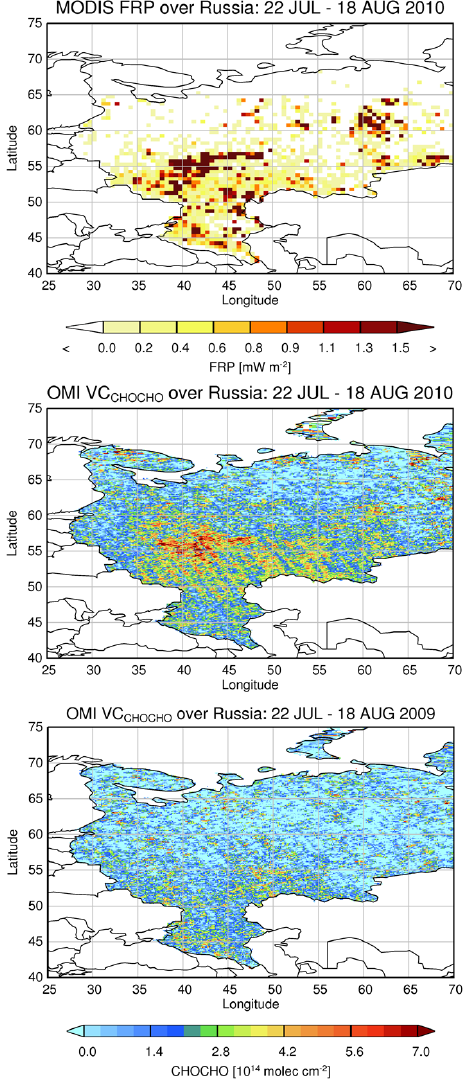
Figure 12. Maps of fire radiative power (top) and glyoxal VCs (mid- dle) over Russia from 22 July to 18 August 2010, as well as glyoxal VCs for the same period in 2009